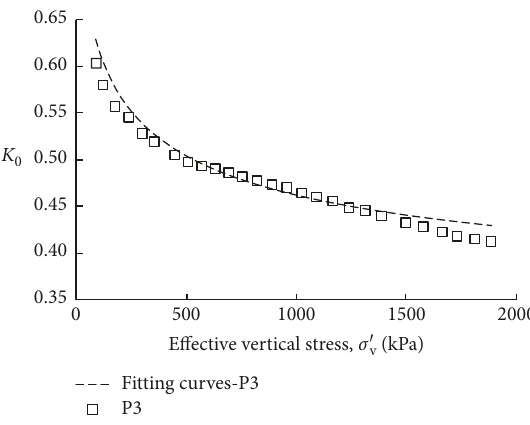
σ v curves for P3. 0 ′ −